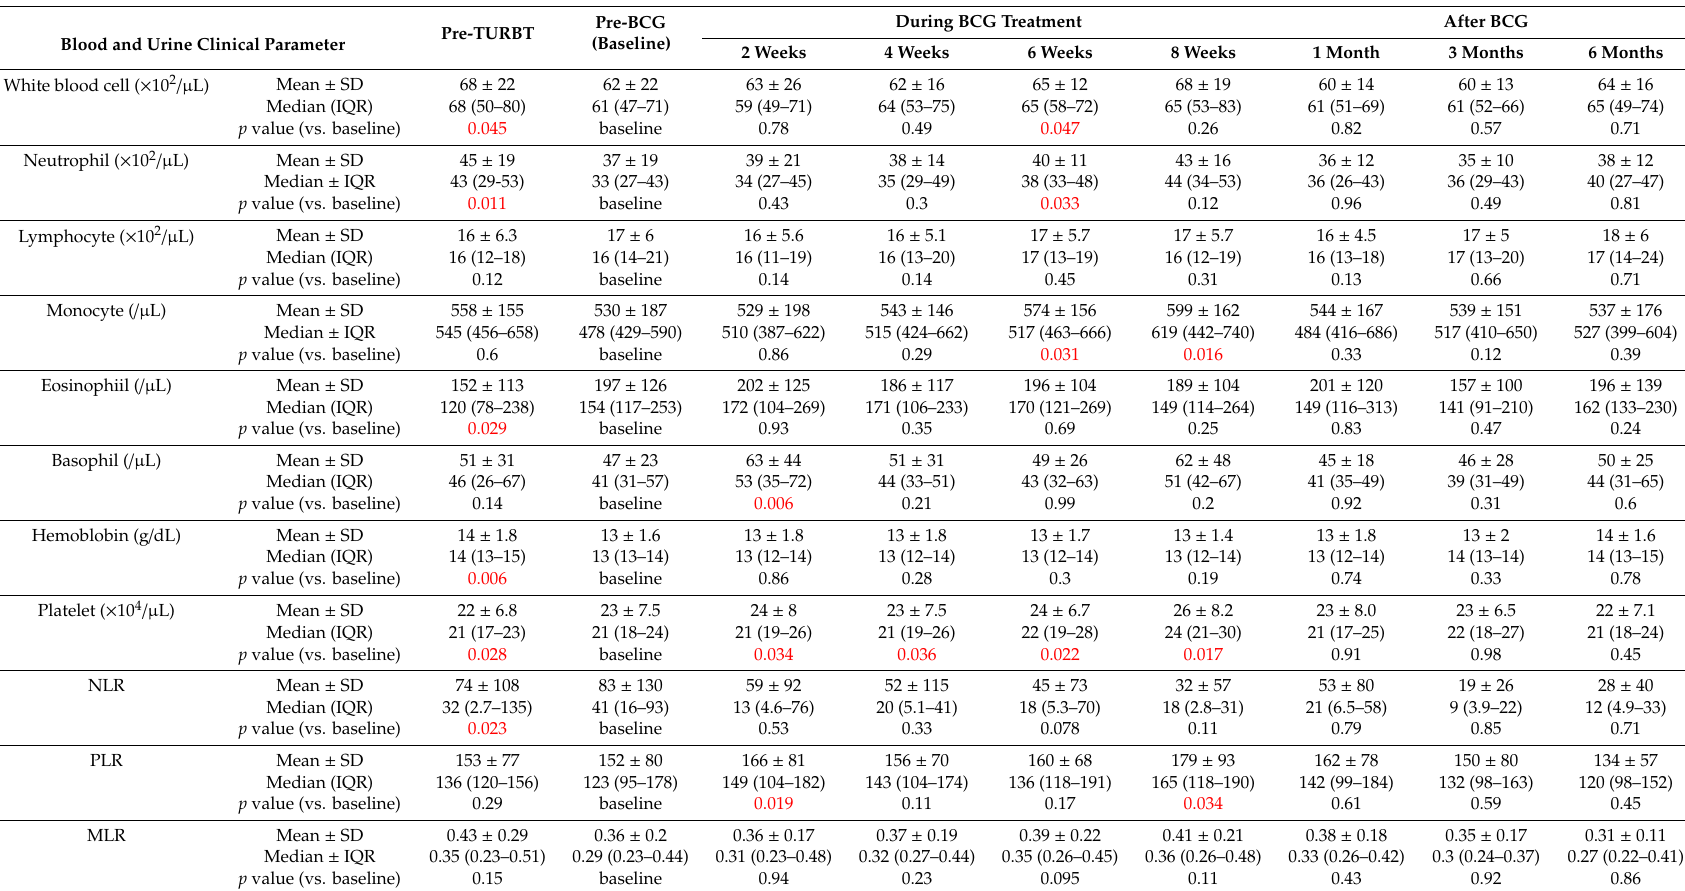
Table 2. Time-course changes in blood and urine clinical parameters before, during, and after intravesical BCG. Blood and Urine Clinical